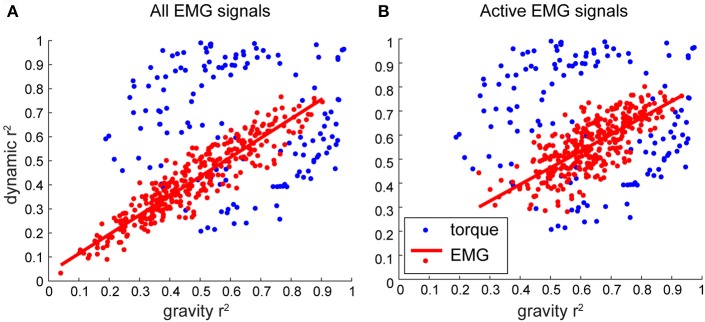
The relative contribution of individual components to EMG and muscle torques across subjects. Each dot represents a value per subject per movement averaged across signals/DOFs. (A) Combined data across subjects. (B) Combined data across subjects, where only variance for conditions when EMG was active >30% of maximal was selected before averaging.